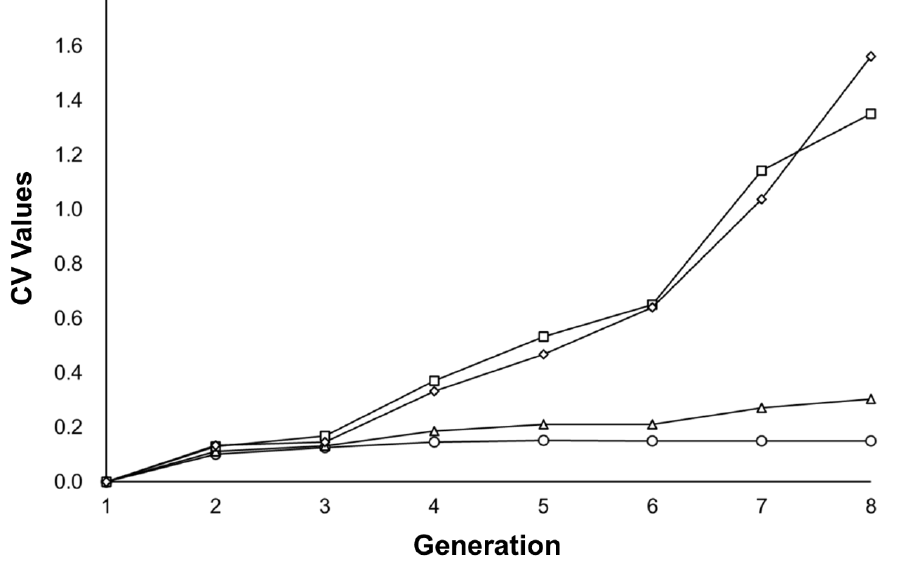
Figure 5. Changes in values of coefficient of variation of the genetic contribution (CV). Circle: autosomes ( CVA ); triangle: X chromosome ( CVX ); square: Y chromosome ( CVY ); rhombus: mitochondrial DNA ( CVM ).